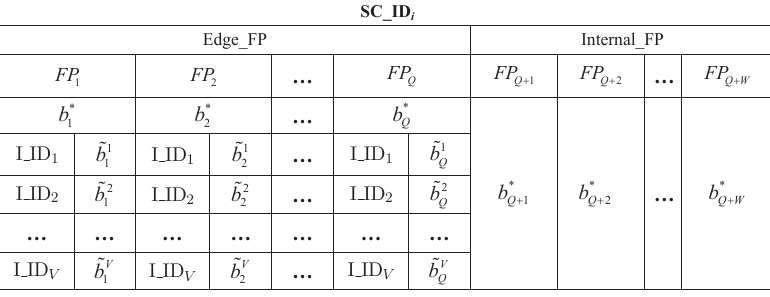
Figure 4. The fingerprint data block of small cell i